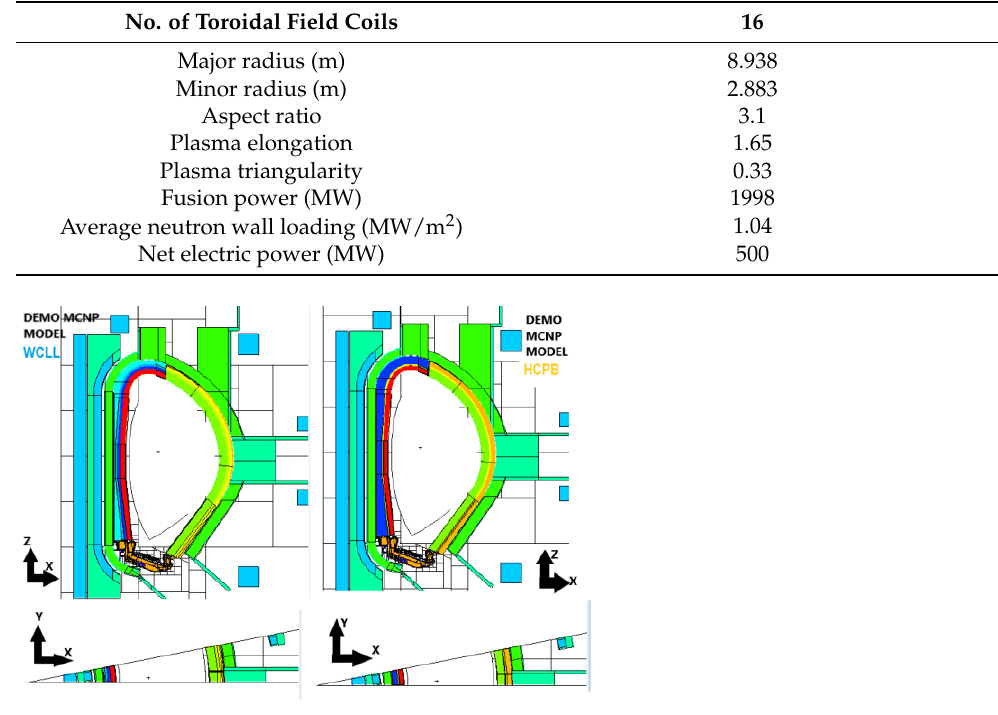
Table 1. Main parameters of the DEMO baseline configuration [42].